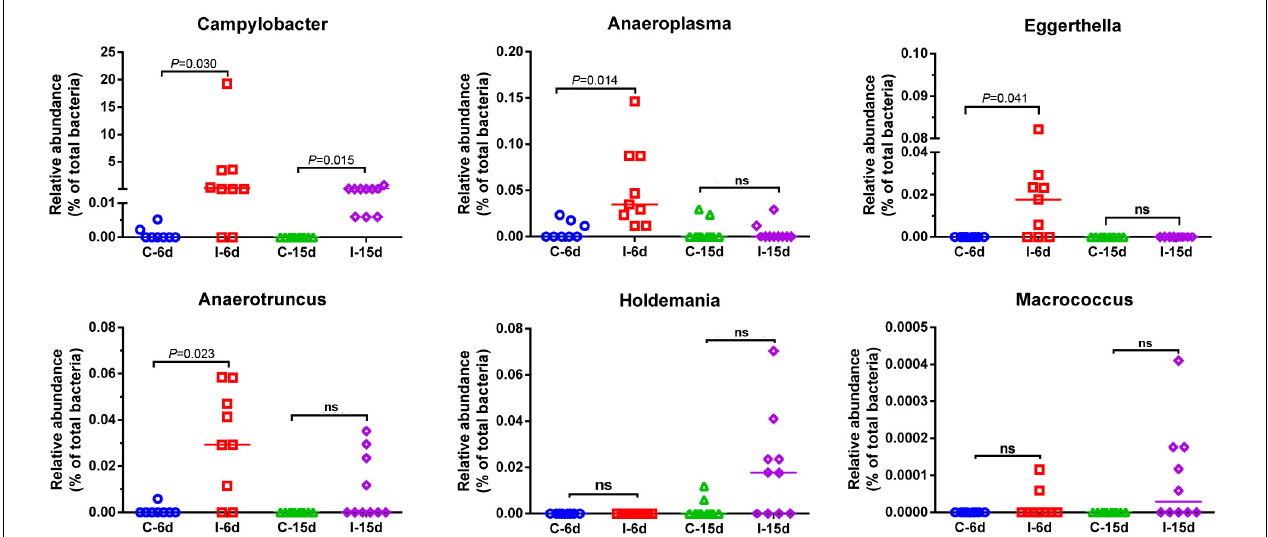
FIGURE 5 | Relative abundance of Campylobacter , Anaeroplasma , Eggerthella , Anaerotruncus , Holdemania, and Macrococcus in the gut microbiota at different post infection time. Values are shown as a fraction of the total bacteria detected within each samples. Lines represent the median value. Statistical tests were performed using post hoc ANOVA and ns indicated no significant